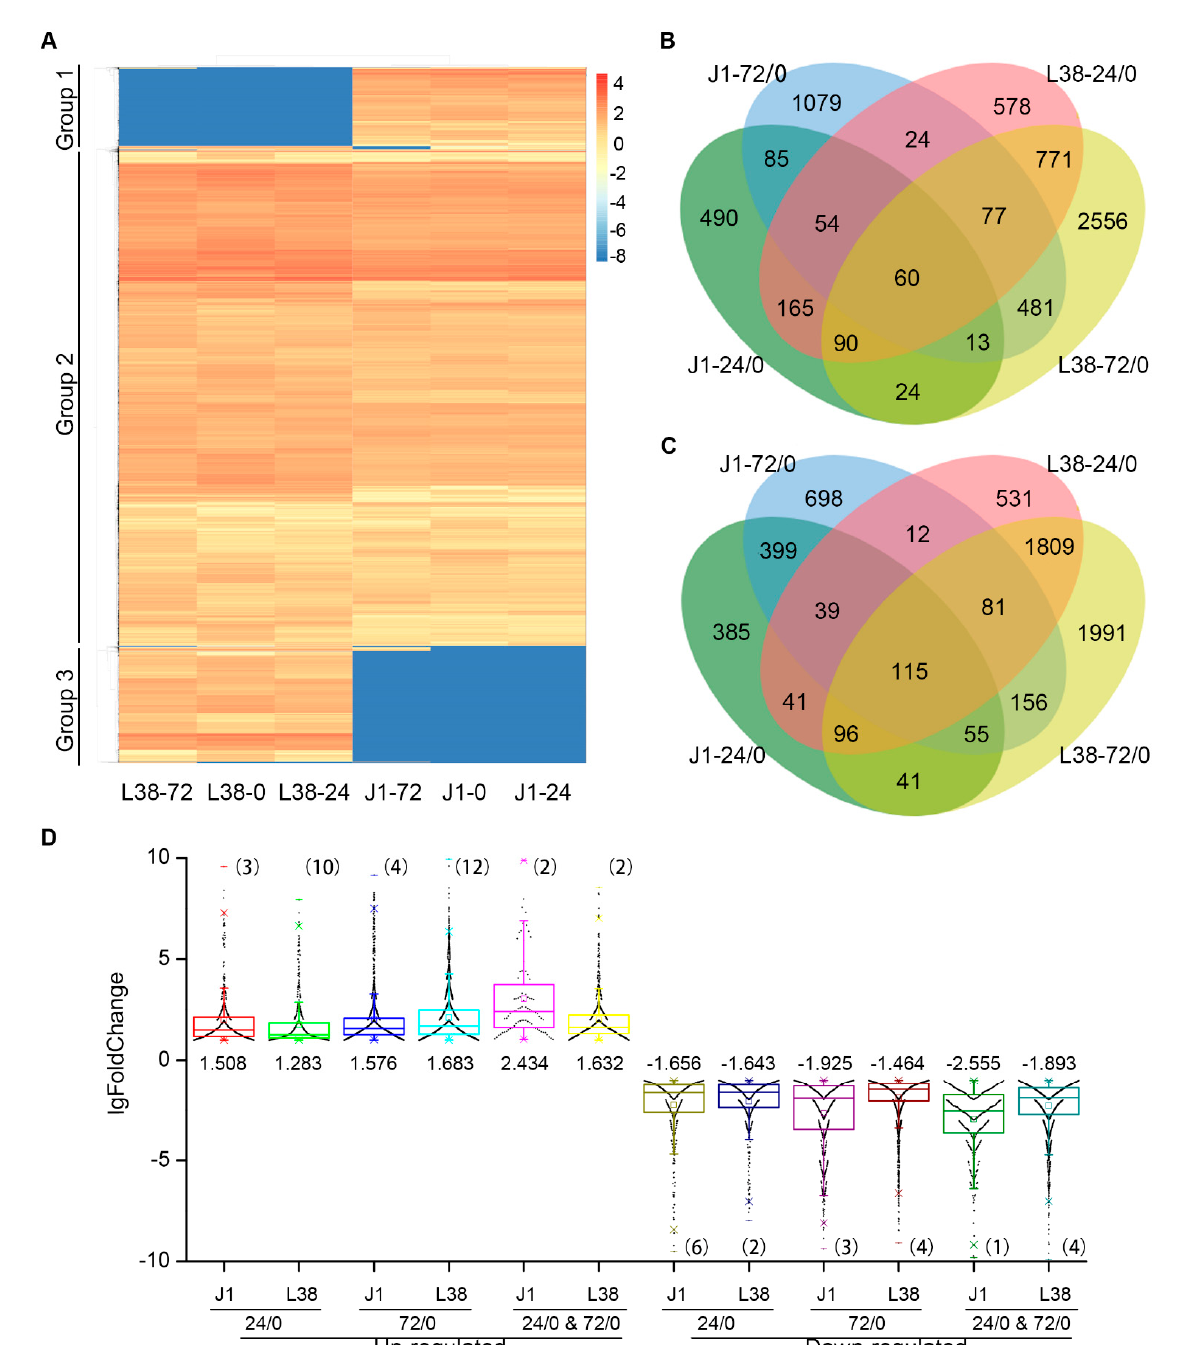
Figure 2. Analysis of differentially expressed genes (DEGs) in J1 and L38 cotton during V. dahliae inoculation. ( A ) Heatmap showed the time course expression profiles of genes annotated in J1 and L38 at 0 h, 24 h, and 72 h, respectively, which was performed by FPKM values of all genes. ( B ) The Venn diagram of the up-regulated DEGs indicated unique and common DEGs for four different comparisons, including J1-24 h/ 0 h (J1-24/0), J1-72/0 h (J1-72/0), L38-24 h/ 0 h (L38-24/0), and L38-72 h/ 0 h (L38-72/0). ( C ) The Venn diagram of the down-regulated differentially expressed genes (DEGs) indicated unique and common DEGs for four different comparisons, including J1-24 h/ 0 h (J1-24/0), J1-72/0 h (J1-72/0), L38-24 h/ 0 h (L38-24/0), and L38-72 h/ 0 h (L38-72/0). ( D ) The fold change of up- and down-regulated DEGs in J1 and L38 at 24/0, 72/0, and both 24/0 and 72/0 (24/0 & 72/0). The numbers indicate the median of all lgfoldchange of DEGs in each group, and the number in bracket indicates the number of DEGs for which lgfoldchange was higher than 10 or lower than −